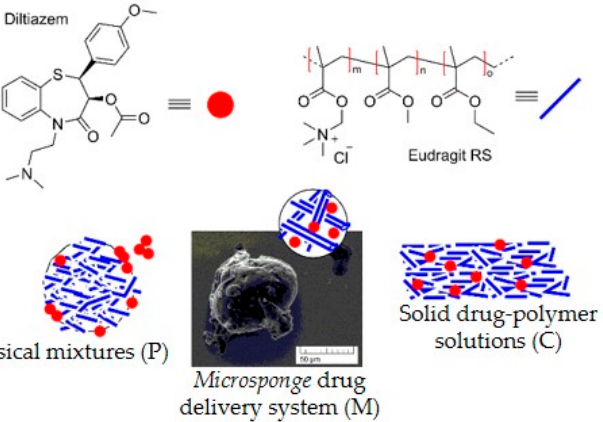
Figure 1. Schematic illustration of diltiazem and Eudragit RS and the expected structural assignment of their composites obtained by different techniques.